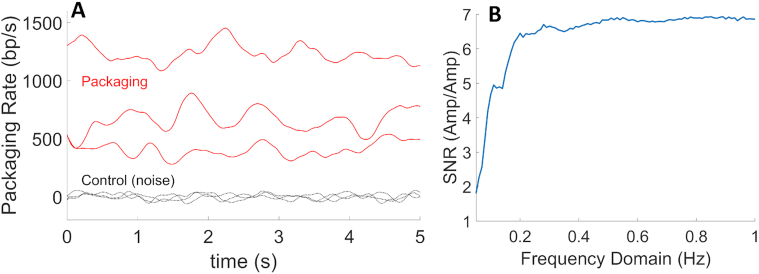
(A) Examples of measured packaging rate versus time with the linear plasmid DNA sequence with 5 pN applied force (top three lines). Shown for comparison are rate fluctuations caused by Brownian and instrumental noise measured in control experiments with fixed tethered DNA molecules (bottom three lines). (B) Signal-to-noise ratio versus frequency determined by calculating the average Fourier transform amplitudes for packaging rate measurements (‘signal’) (from N = 134 packaging events) and dividing them by the average amplitudes calculated from control (‘noise’) rate measurements.